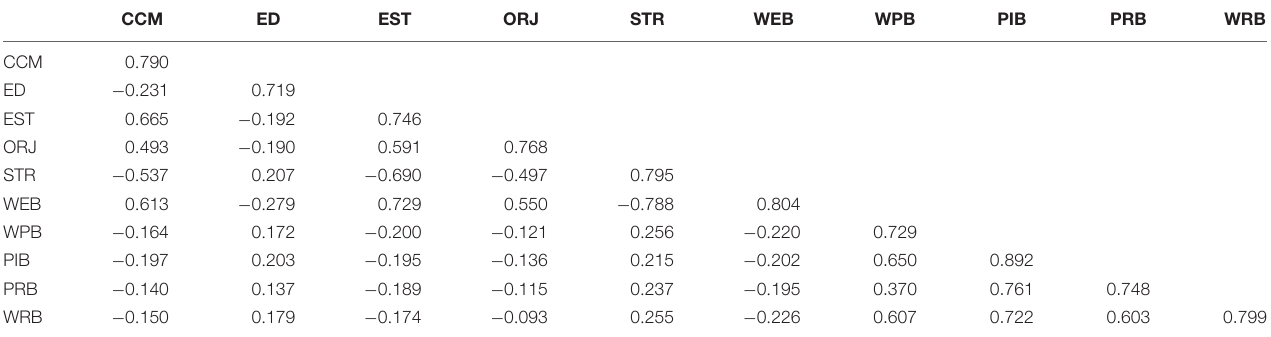
TABLE 2 | Fornell-Larcker criterion.